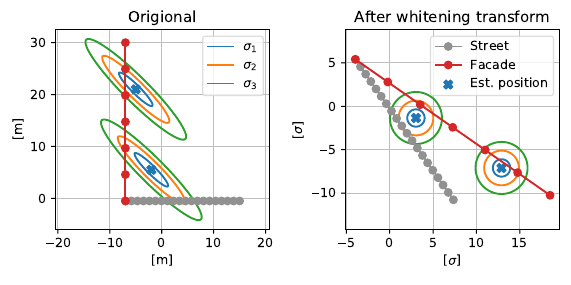
Figure 5. Effect of the Whitening